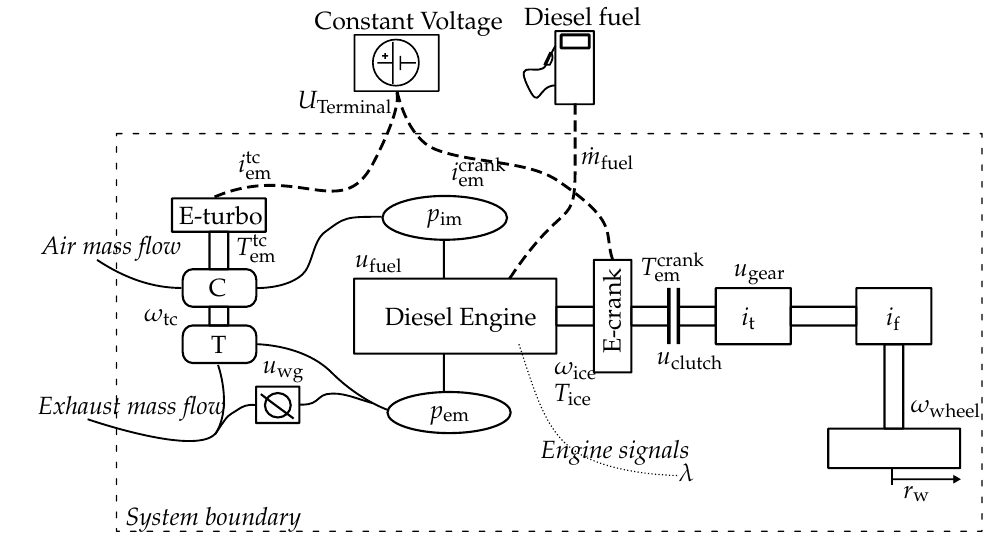
Figure 1. Terminology used to describe the diesel engine and the electric